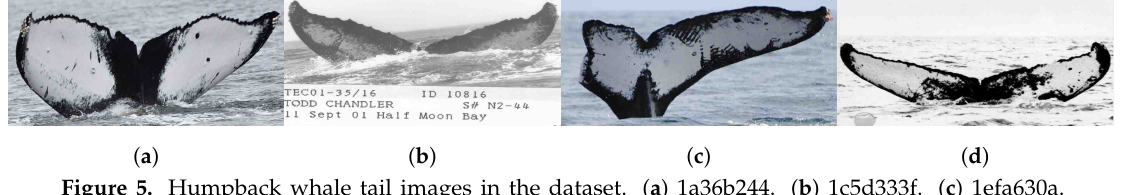
Figure 5. Humpback whale tail images in the dataset. ( a ) 1a36b244. ( b ) 1c5d333f. ( c ) 1efa630a. ( d )